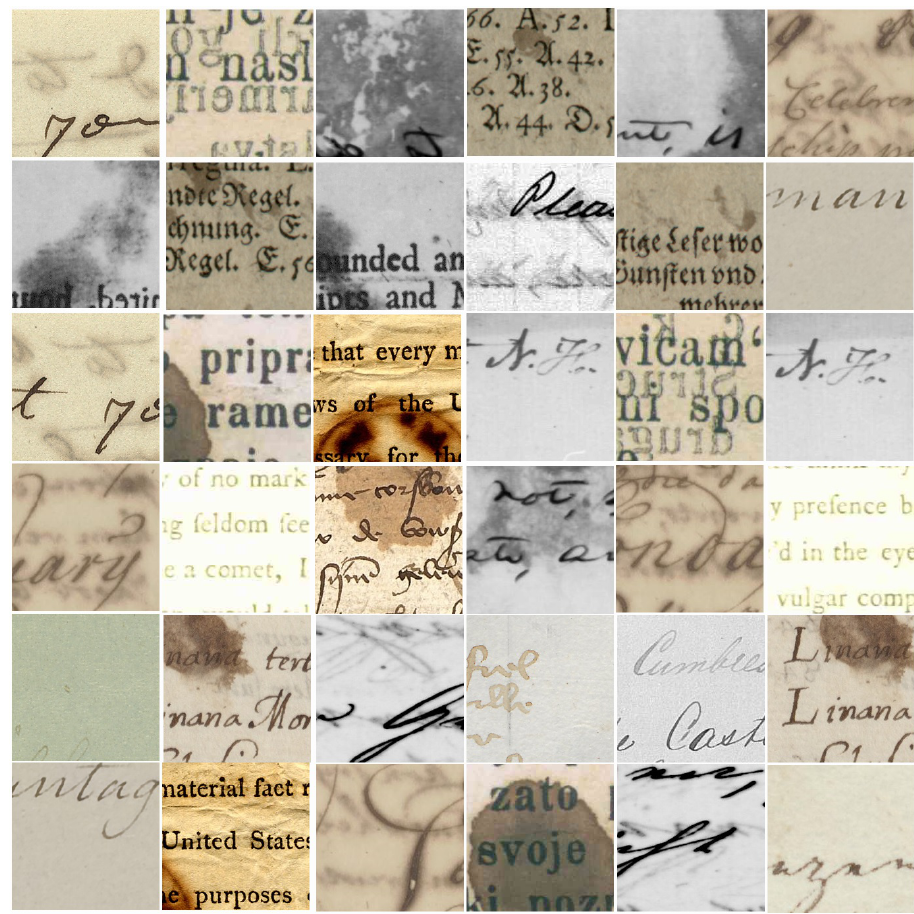
Figure 5. Example of image patches used for data training